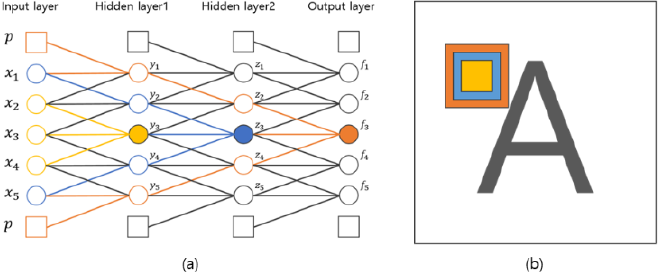
Figure 5. Influence of the number of convolution layers. ( a ) Influence on neural networks; ( b ) influence on 2D images.